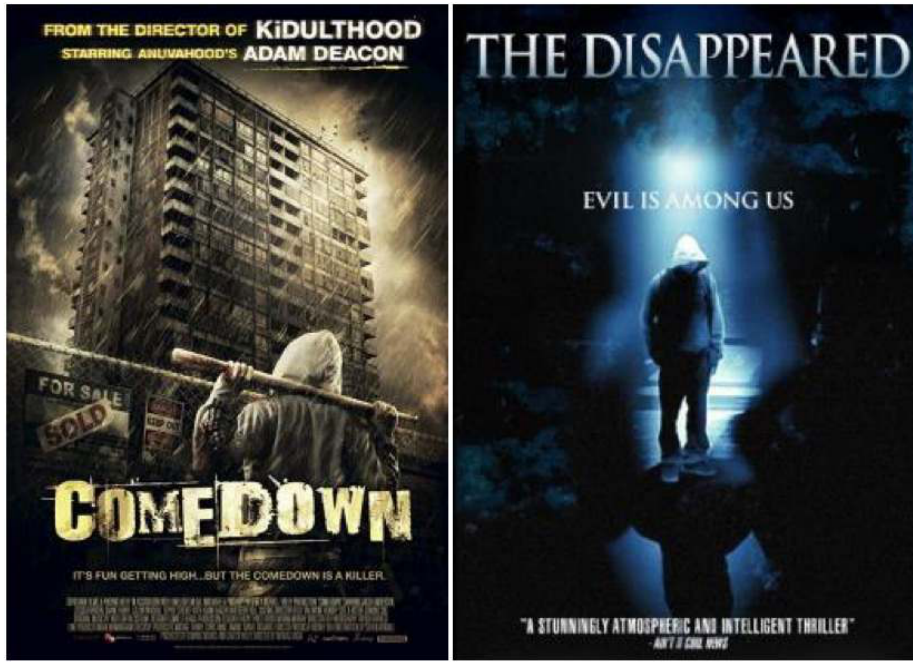
Figure 6. One villain may hide